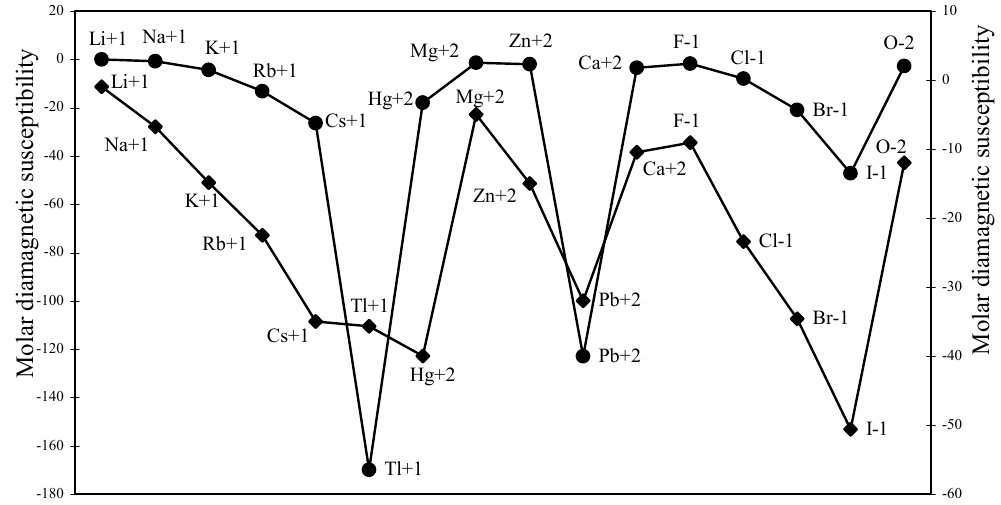
Figure 25. Plot of molar diamagnetic susceptibility of some typical